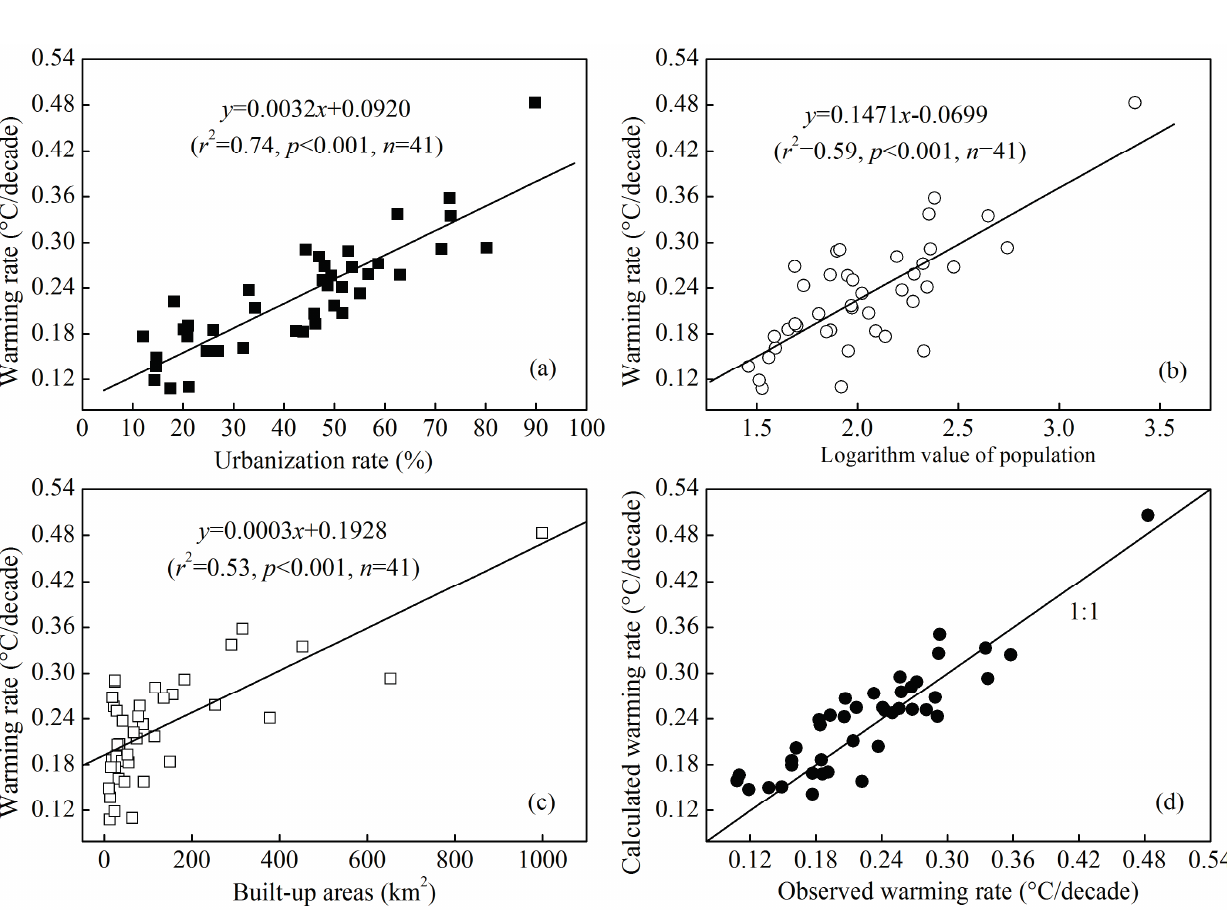
Figure 6. Linear relationships between the urbanization rate ( a ), population ( b ), built-up areas ( c ) and the warming rate of average air temperature for all 41 stations in the YRDUA. Comparison of the observed warming rate from the fit of the yearly mean daily air temperature vs. year as calculated from the multiple linear regression using the urbanization rate, population, and built-up area ( d